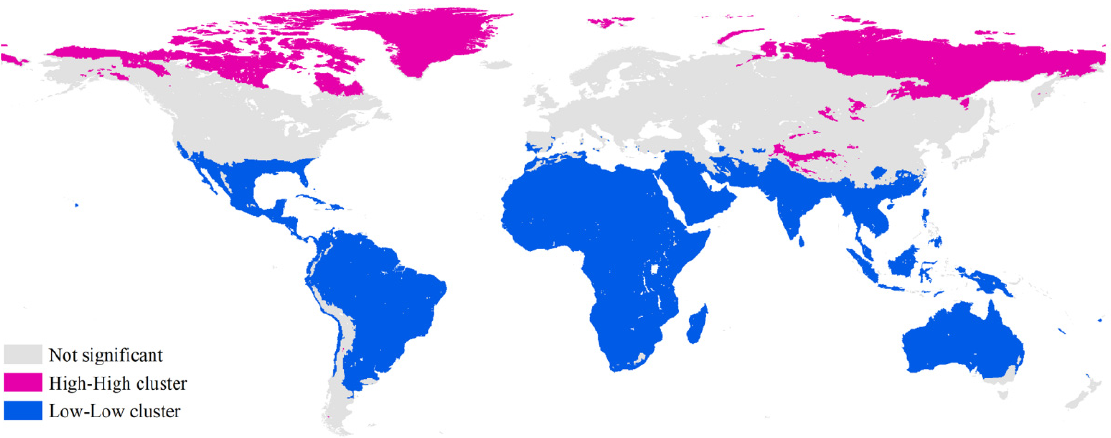
Figure 2. Spatial pattern of global heating degree days based on Anselin Local Moran Index.